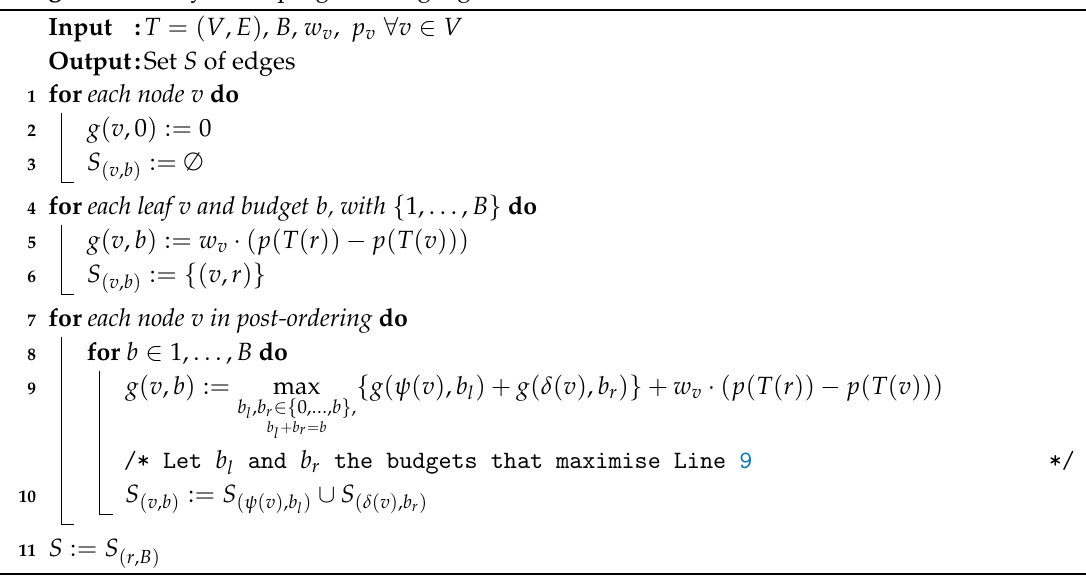
Algorithm 1: Dynamic programming algorithm for MCI.